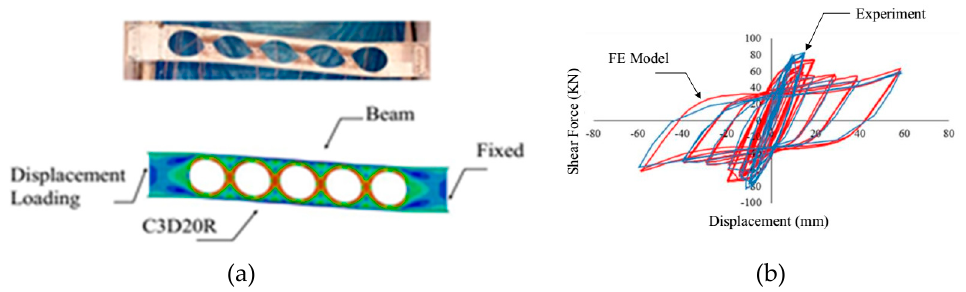
Figure 6. Verification of the finite element modeling methodology against laboratory test [17]. ( a ) FEA model; ( b ) Comparison of FEA with test.